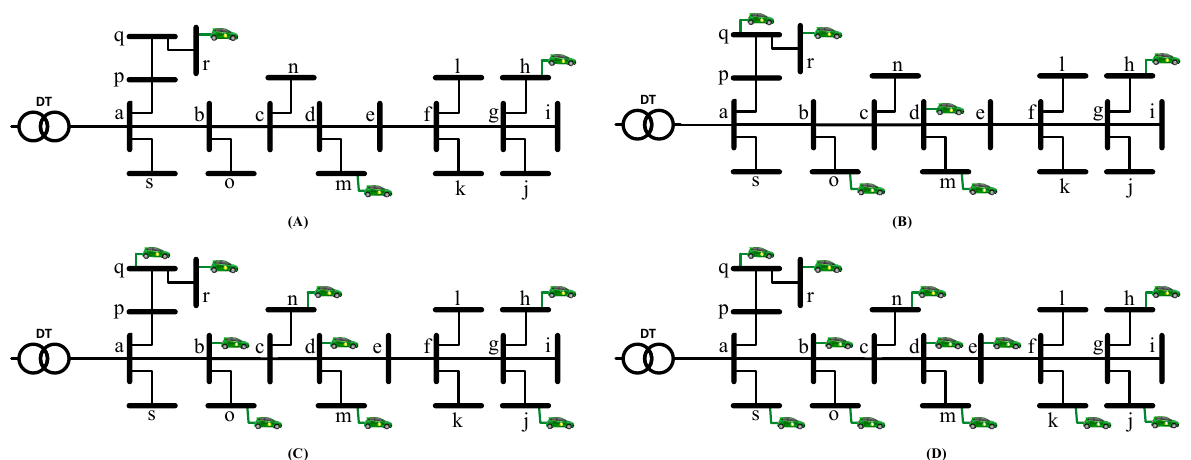
Figure 5. Selected nodes of LV feeders for EVs’ connection for different penetration levels: ( A ) = 16%; ( B ) = 32%; ( C ) = 47% and ( D ) = 63%).